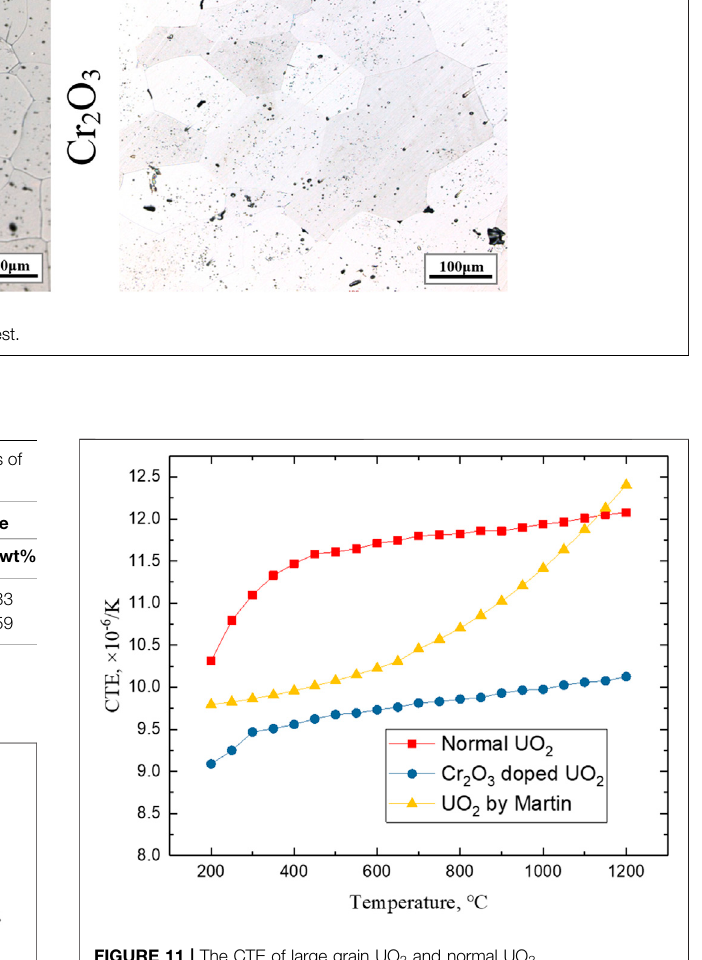
2 and normal UO 2